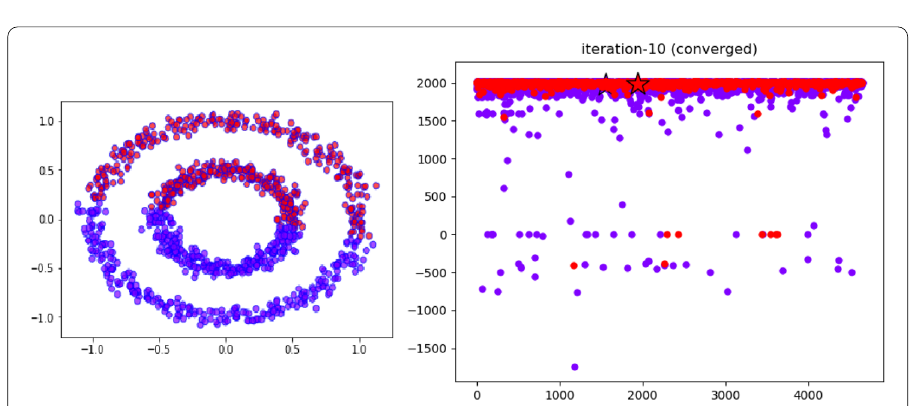
Fig. 2 K-means clustering in 2